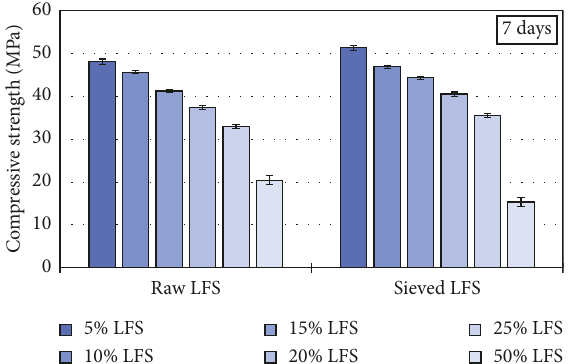
Figure 12: Compressive strength (nominal 7 days) of LFS-blended HTAC mortars (7 days include 46 hours high-temperature curing at 50 ± 1 °